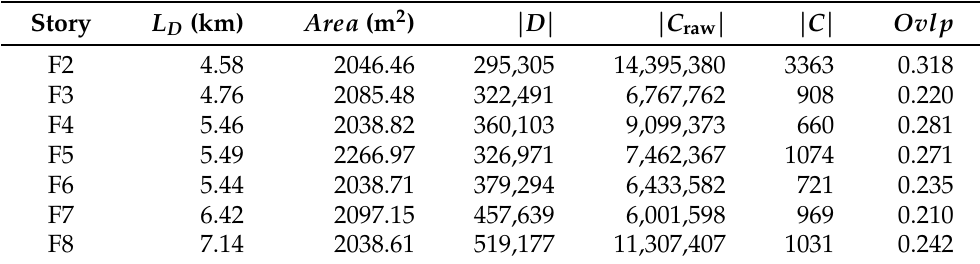
Figure 7. The CAD drawings and smartphone’s 3D point clouds of the seven test cases. Table 1. List of the as-designed and as-built data sets from seven different floor